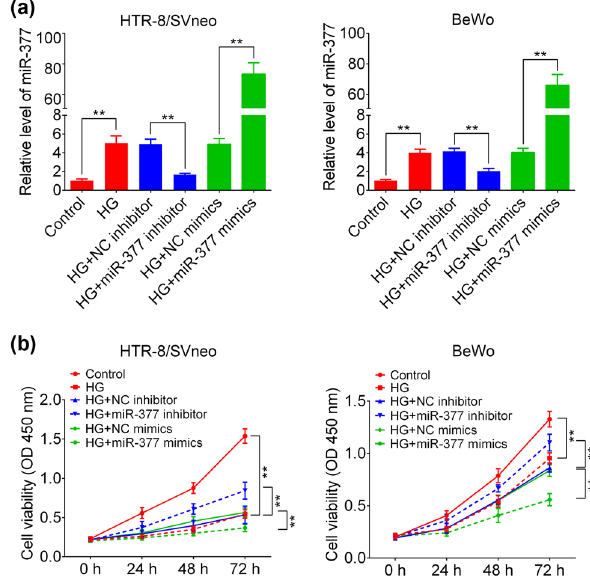
Figure 2: E ff ect of miR - 377 - 3p on HTR - 8/SVneo and BeWo cells. ( a ) miR - 377 - 3p expression in HTR - 8/SVneo and BeWo cells ( control or HG ) with transfection of miR - 377 - 3p inhibitor, miR - 377 - 3p mimic, NC mimic or NC inhibitor. ( b ) Cell growth curves of HTR - 8/SVneo and BeWo cells ( control or HG ) with transfection of miR - 377 - 3p inhibitor, miR - 377 - 3p mimic, NC mimic or NC inhibitor. The data are expressed as mean ± SEM. ** indicates p <